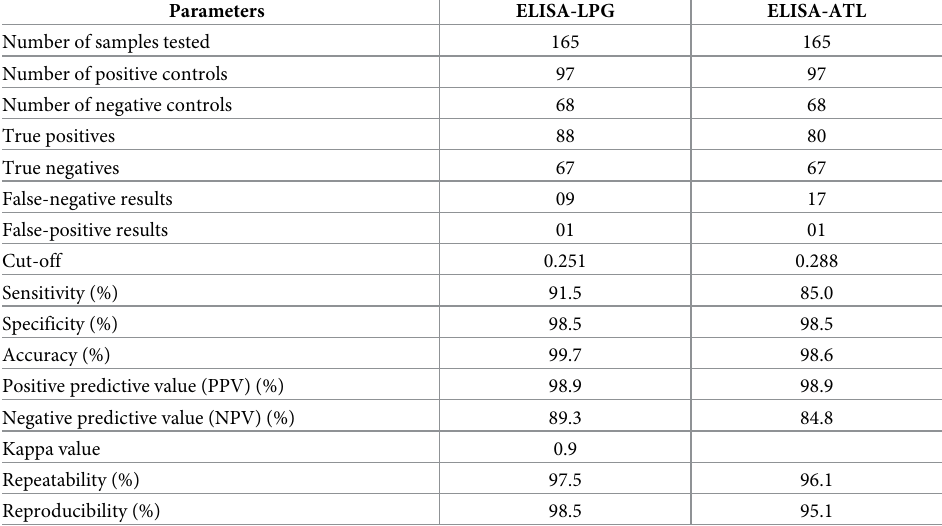
Table 2. Results from the canine visceral leishmaniasis positive and negative controls tested by the LPG and TLA ELISAs and consequent validation parameters. These parameters were calculated using the results found at each assay made with the optimized conditions. The accuracies were calculated as the areas under the ROC curves (AUC). Parameters